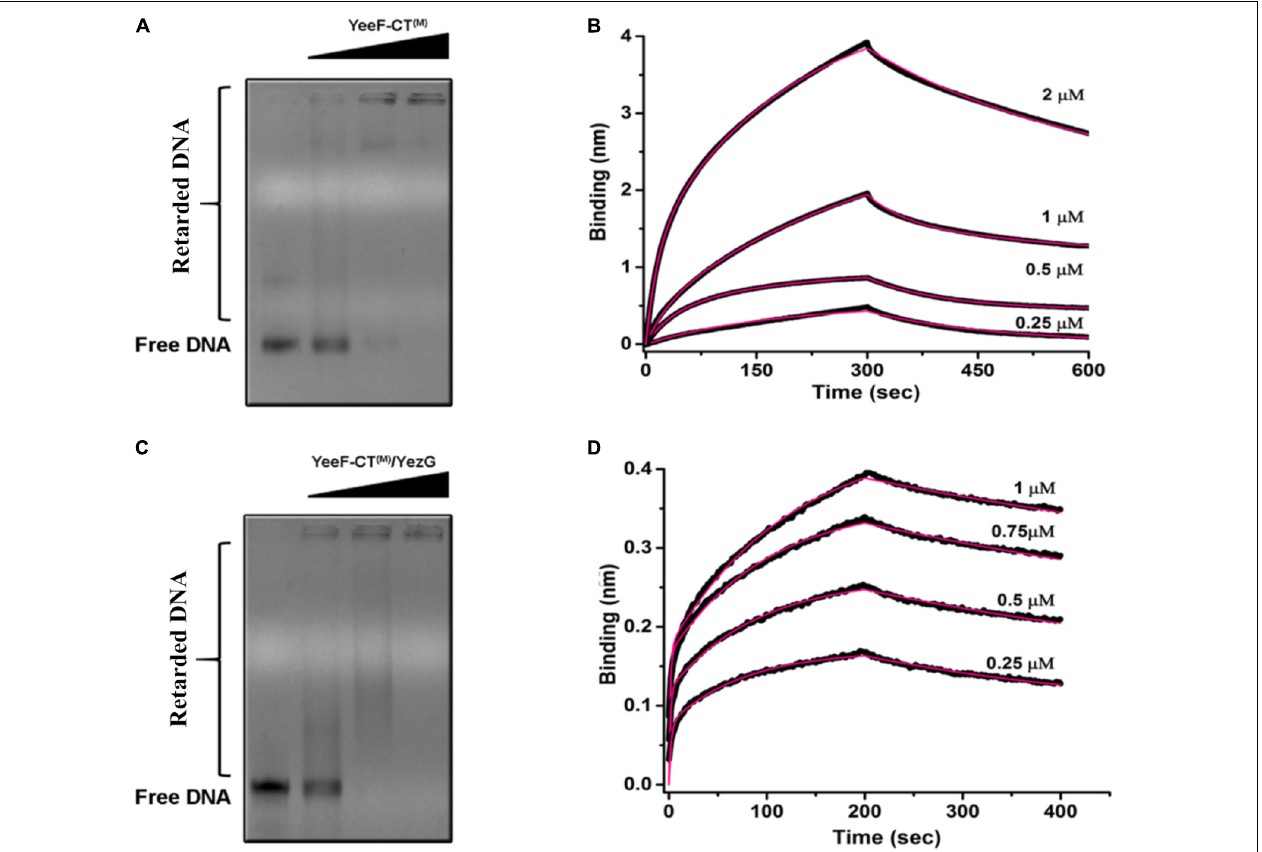
FIGURE 5 | DNA binding property of YeeF-CT ( M ) and YeeF-CT ( M ) /YezG. (A) YeeF-CT ( M ) exhibits non-specific DNA binding property. A smear of retarded DNA can be visualized in the agarose gel. With an increase in the concentration of YeeF-CT ( M ) the mobility of the DNA-protein complex is retarded and is stuck in the well. (B) BLI kinetics showing binding of non-specific dsDNA with YeeF-CT ( M ) . (C,D) Binding of YezG did not alter the DNA binding property of YeeF-CT ( M ) . (C) The agarose gel electrophoresis of DNA incubated with different concentrations of YeeF-CT ( M ) /YezG show retardation in DNA mobility. (D) BLI kinetics showing binding of non-specific dsDNA with YeeF-CT ( M ) /YezG. Both raw sensorgrams (black lines) and fitted curves (red lines) are shown in the